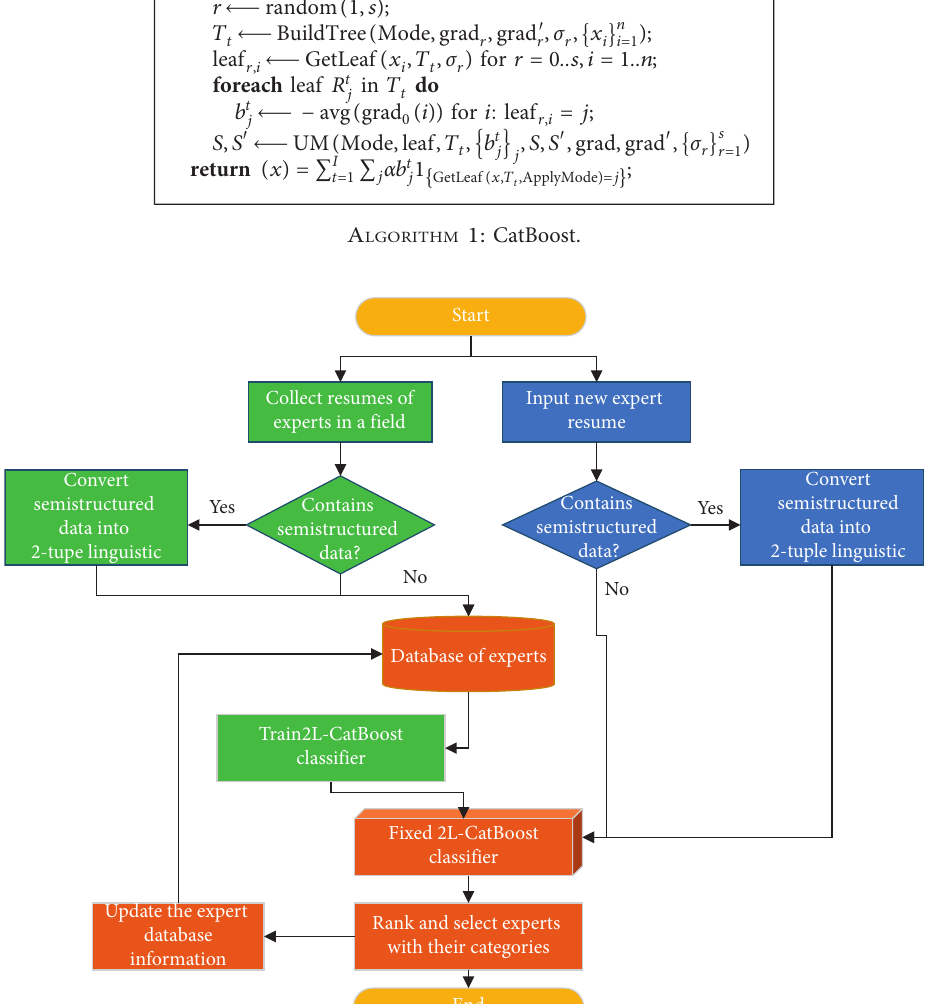
Figure 1: The process of expert classification and